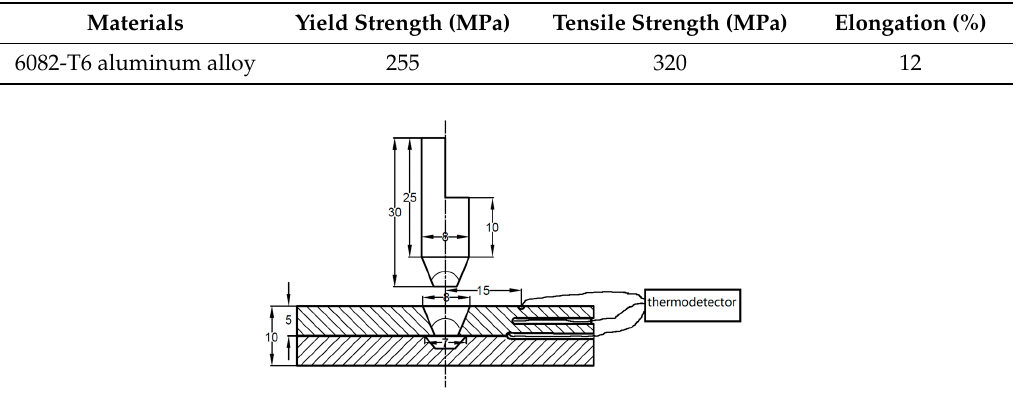
Table 1. The mechanical property of 6082-T6 aluminum alloy.